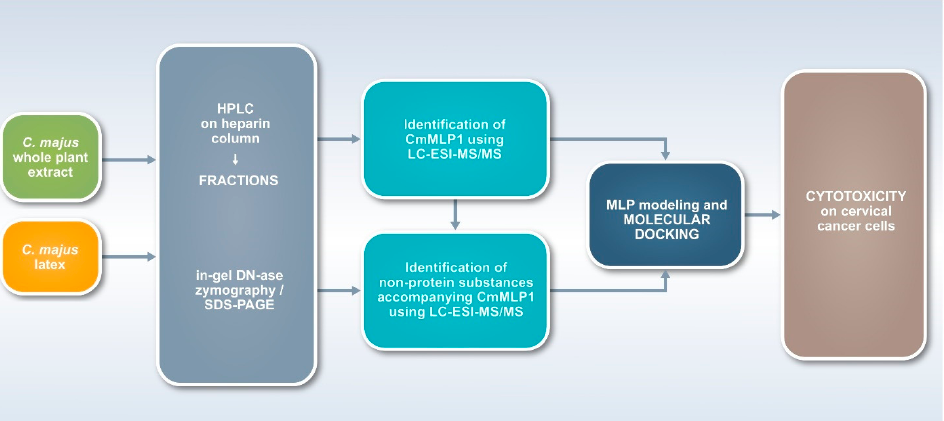
Figure 1. Workflow for the multidisciplinary study (toolbox) for two kinds of plants source materials— C. majus extracts and latex. The research scheme enabled fractionation with the use of affinity chromatography, monitoring of all fractions with the use of proteomic, zymography, as well as LC-ESI-MS/MS techniques for the identification of proteins and non-protein substances. Molecular interactions were confirmed with the use of bioinformatic tools of molecular modeling and docking, and their biological activities were finally analyzed using cell lines.